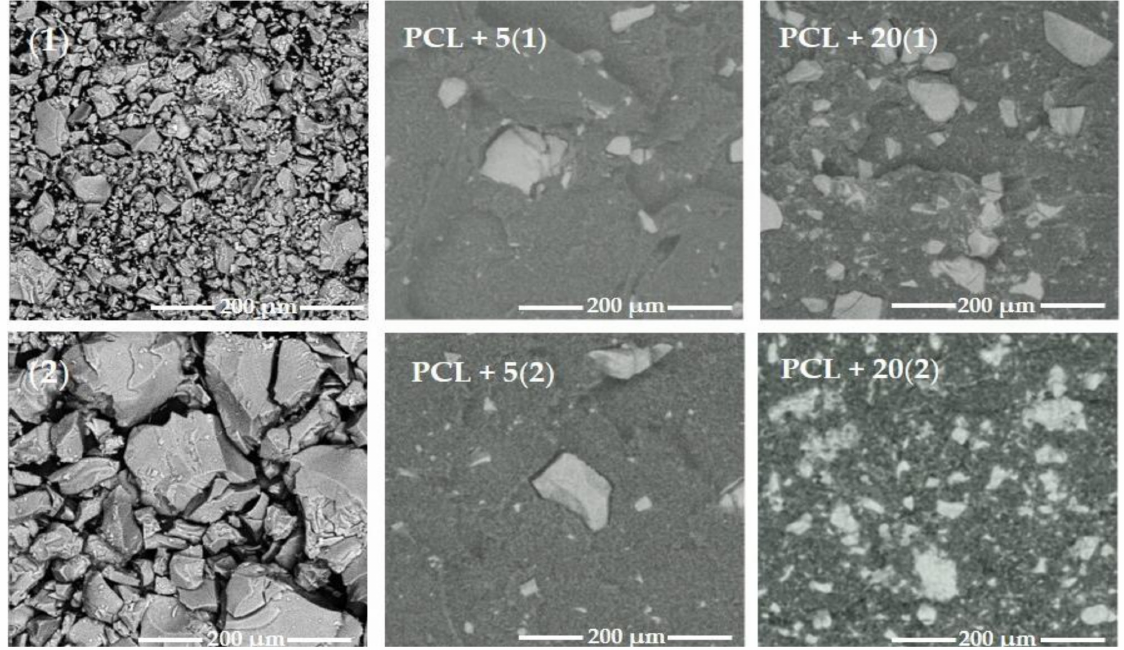
Figure 1. SEM images of isolated micro-powders of oxo-complexes ( 1 ) and ( 2 ) and cross sections of the produced PCL + n TOCs (TOCs = ( 1 ) and ( 2) ) composite